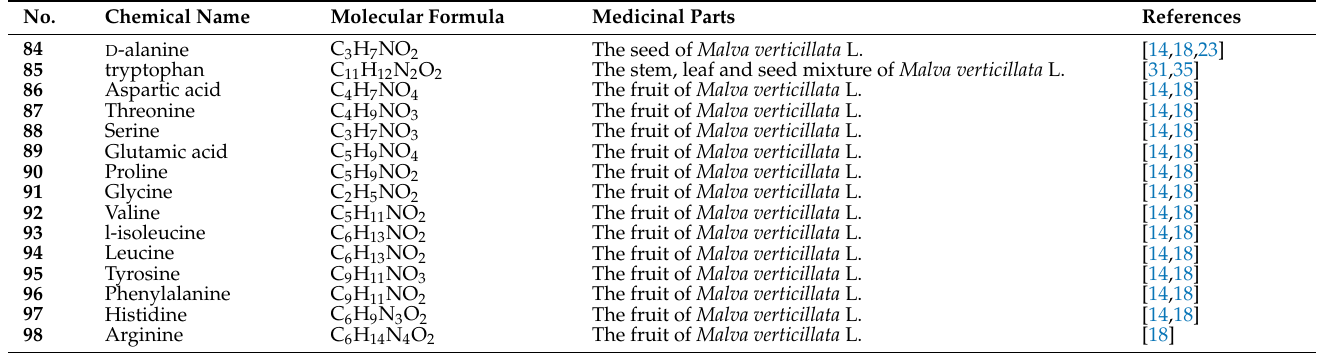
Table 7. The amino acids identified from Fructus Malvae.